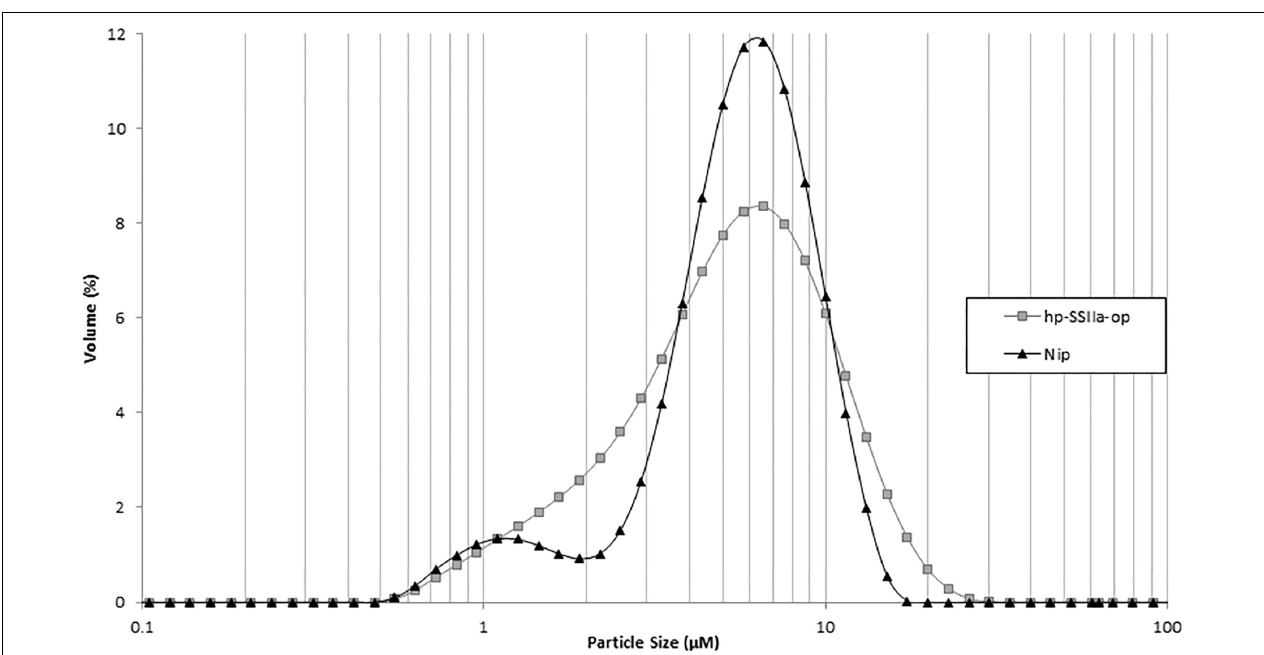
FIGURE 3 | Particle size analysis of representative hp-SSIIa-op (SS5) in comparison with the control Nipponbare (Nip). The y -axis represents the amount of each size of starch granules as a percentage of total starch. The x -axis represents the size of starch granules. The names of lines are labeled on the right of the graph.